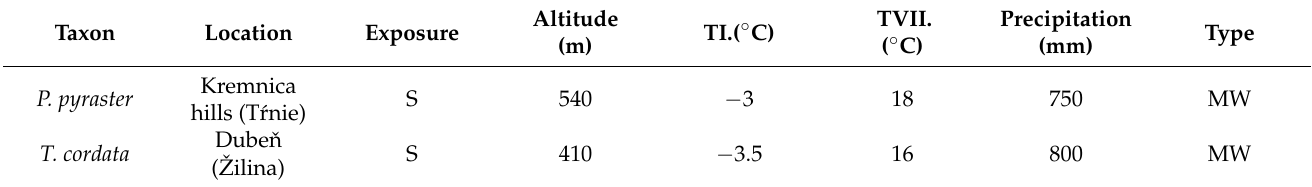
Table 1. The source stand conditions are given according to the climatic characteristics [27] of the regions in Slovakia in which they are